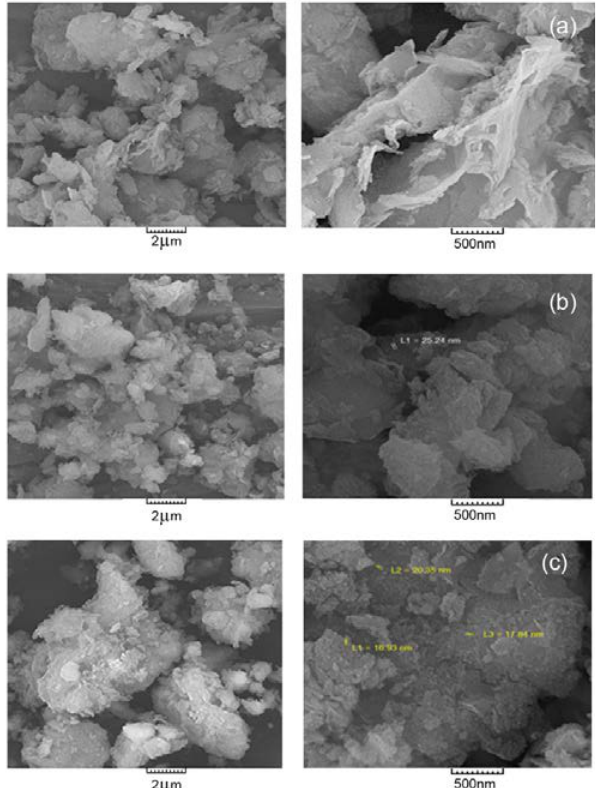
Fig. 1. The SEM images of (a) bentonite, (b) Nd –TiO2/bentonite and (c) Ce-TiO2/bentonite